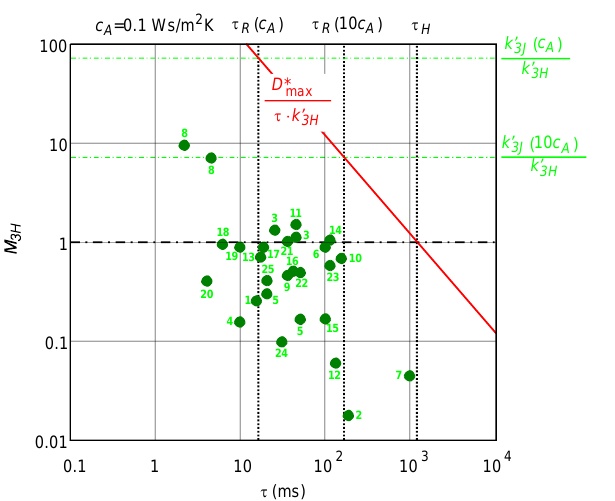
Figure 4. Dimensionless figure of merit M 3H measuring D ∗ /τ of the thermoelectric radiation sensors plotted in Fig. 3 in units of k 0 For the limiting value k 0 ( c A ) cf. Eq. 3J